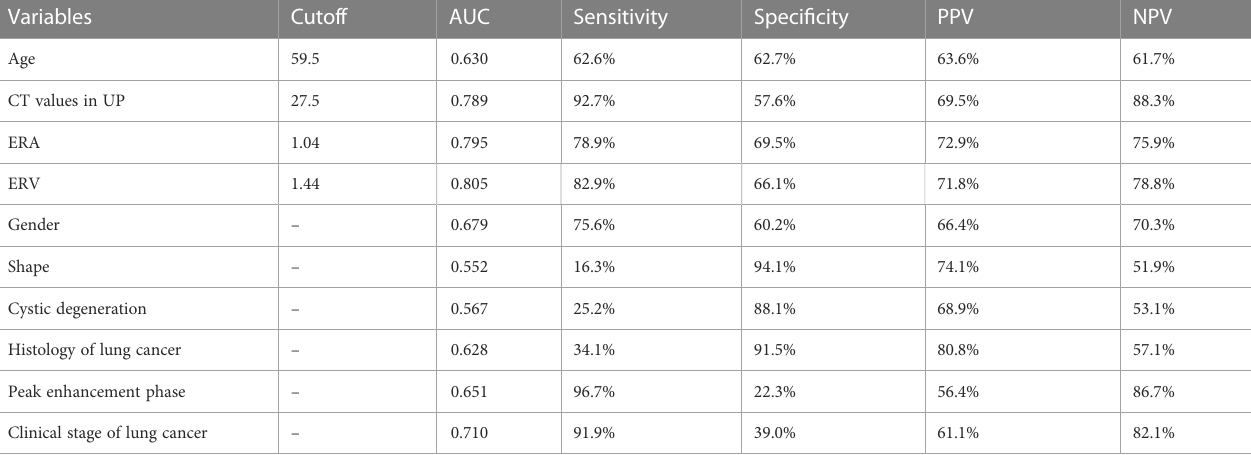
TABLE 1 Individual variables obtained from ROC analysis for differentiation of LAPs from